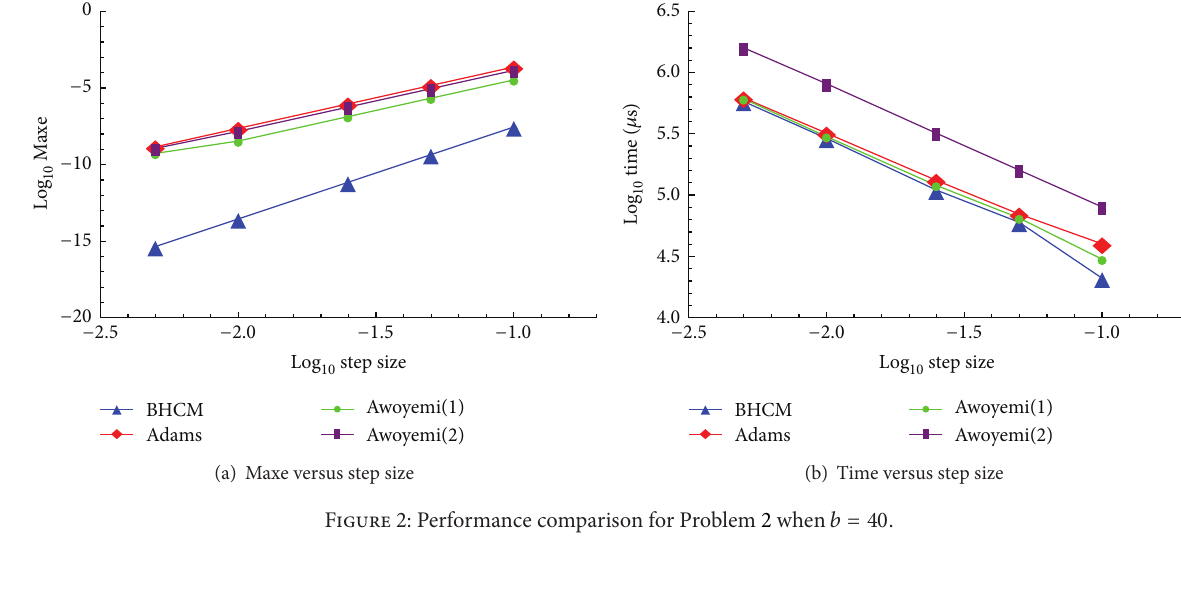
Table 5: Numerical results for problem in Thin Film Flow (29) with ℎ = 0.1, 𝑘 = 2 .